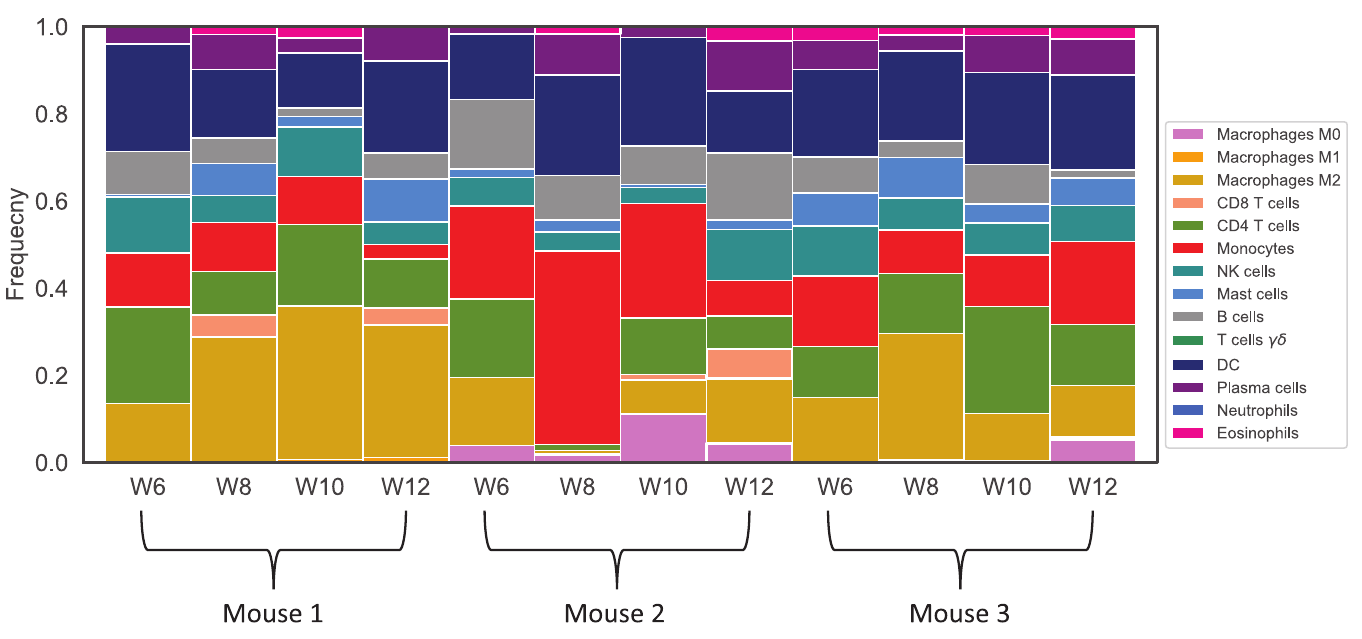
Fig 2. Immune cell frequencies for each mouse at different time points. Results acquired from deconvolution of gene expression data at each time point using CIBERSORTx B-mode.